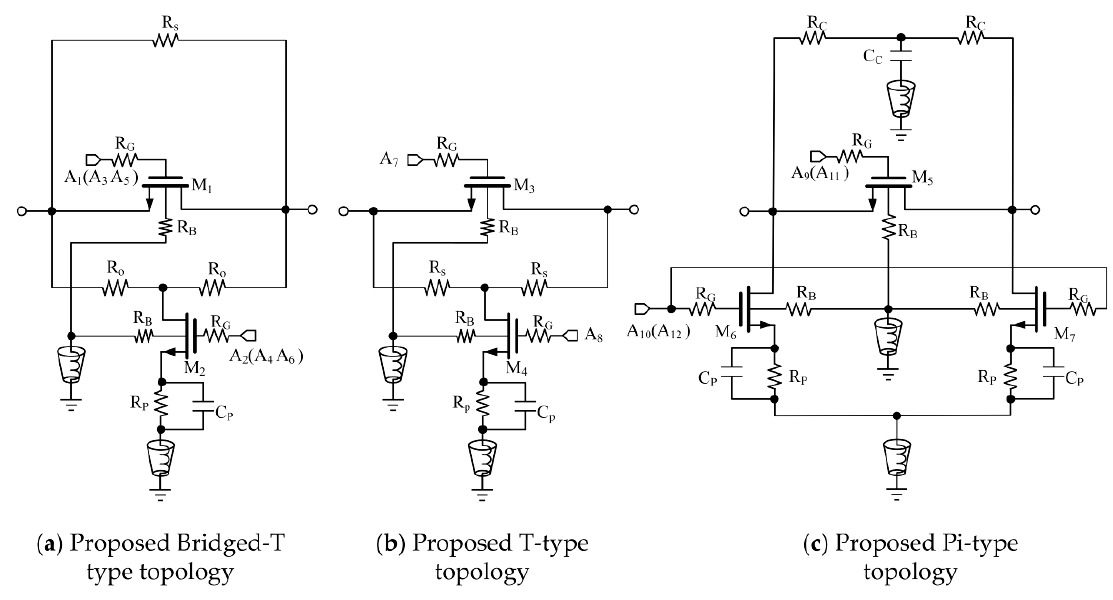
Figure 8. The utilized attenuation cell topology in 6-bit CMOS digital control step attenuator, ( a ) Proposed Bridged-T type topology, ( b ) Proposed T-type topology and ( c ) Proposed Pi-type topology.